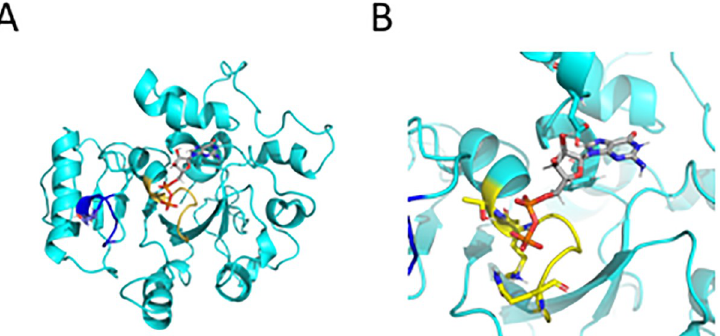
Fig 2. Modelling of the GTP binding domain of Tg DrpC (A) Monomer model for Tg DrpC GTPase domain. The P- loop responsible for tri/diphosphate binding is indicated in yellow, while the switch I region with the putative MG 2+ coordinating threonine is in blue. (B) close-up of the GDP binding site after molecular dynamics simulation with key residue interacting to the co-substrate shown in ball-and-stick representation, yellow for residues in the P-loop, cyan for residues interacting with the ribose and the guanine.